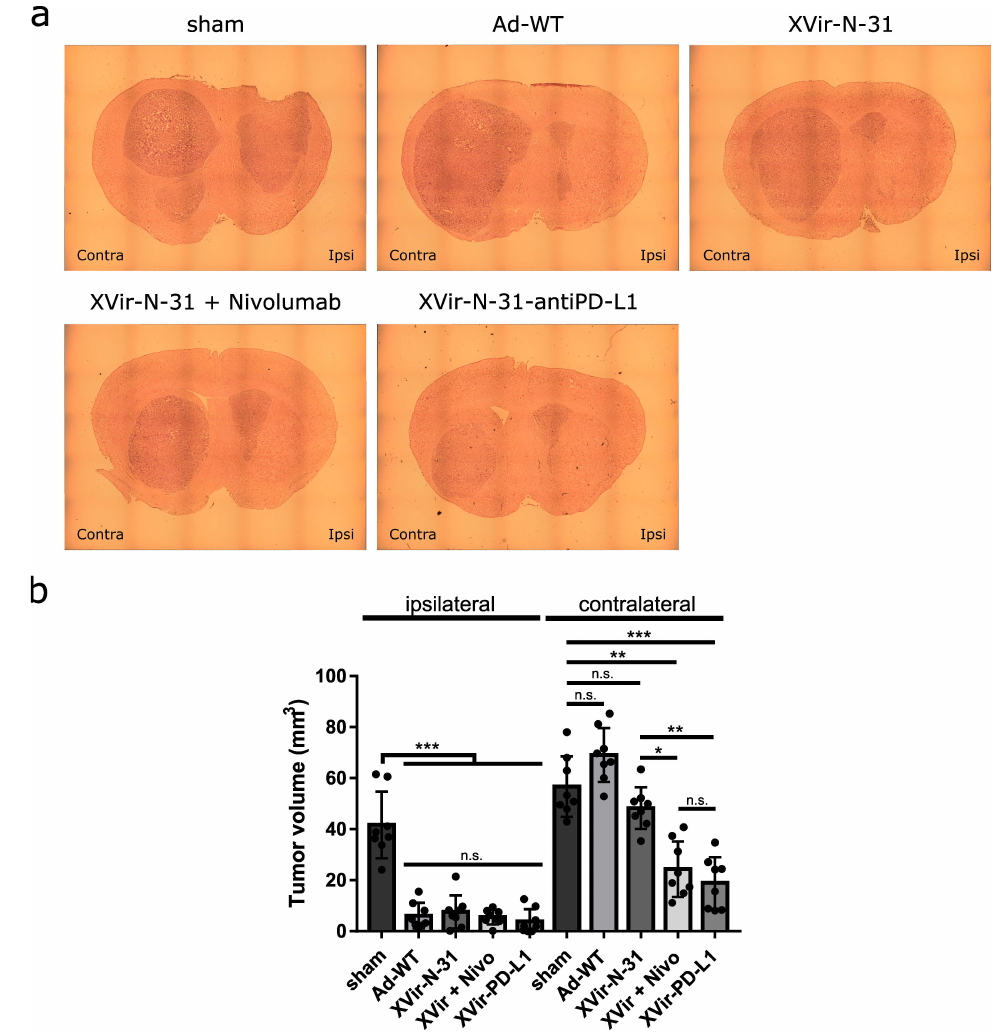
Figure 7. Reduction of tumor growth. ( a ) Representative pictures of brain sections of the U87MG tumor bearing, immuno-humanized NSG mice. The ipsilaterally growing tumor was injected with either PBS (sham), 3 × 10 8 IFU Ad-WT, XVir-N-31, or XVir-N-31-anti-PD-L1. One group addition- ally received repeated systemic injections with nivolumab, as indicated in the Methods section. ( b ) Quantification of the tumor volume (mm 3 ; XVir-PD-L1: XVir-N-31-anti-PD-L1; n = 7–8 mice per group, SEM; n.s.: not significant; * p < 0.05, ** p < 0.01, *** p <